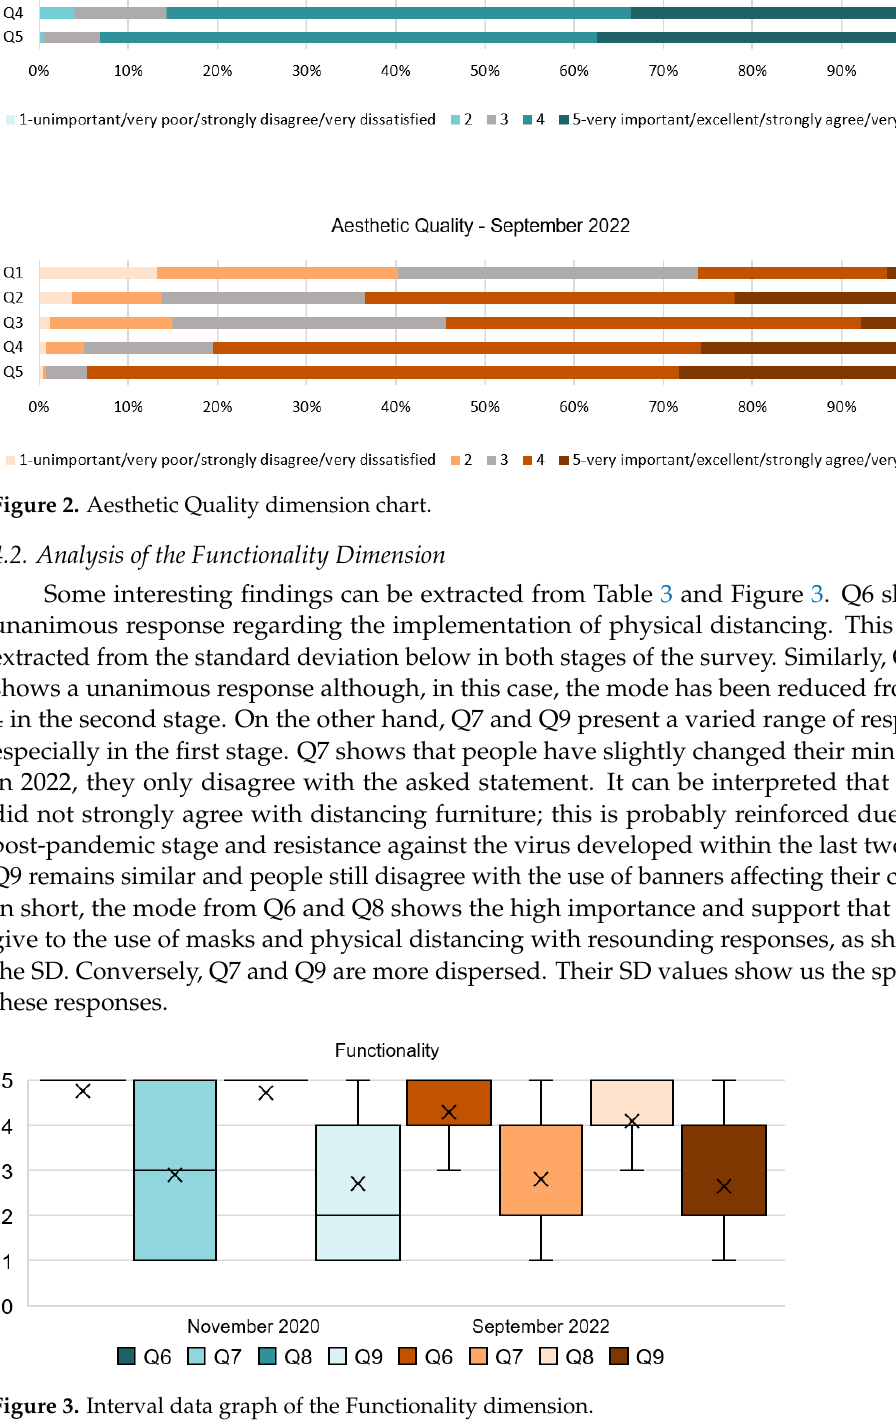
Figure 3. Interval data graph of the Functionality dimension.